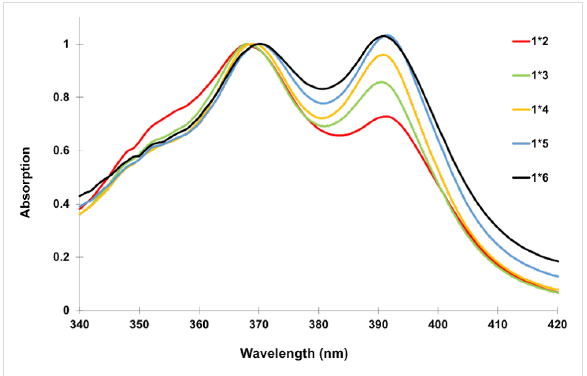
Figure 4 focuses on the vibronic bands of pyrene’s S 0 → S 1 absorption band in duplexes 1 * 2 to 1 * 6 . An increasing number of PDIs in a stack leads to a stronger vibronic band at 390 nm.